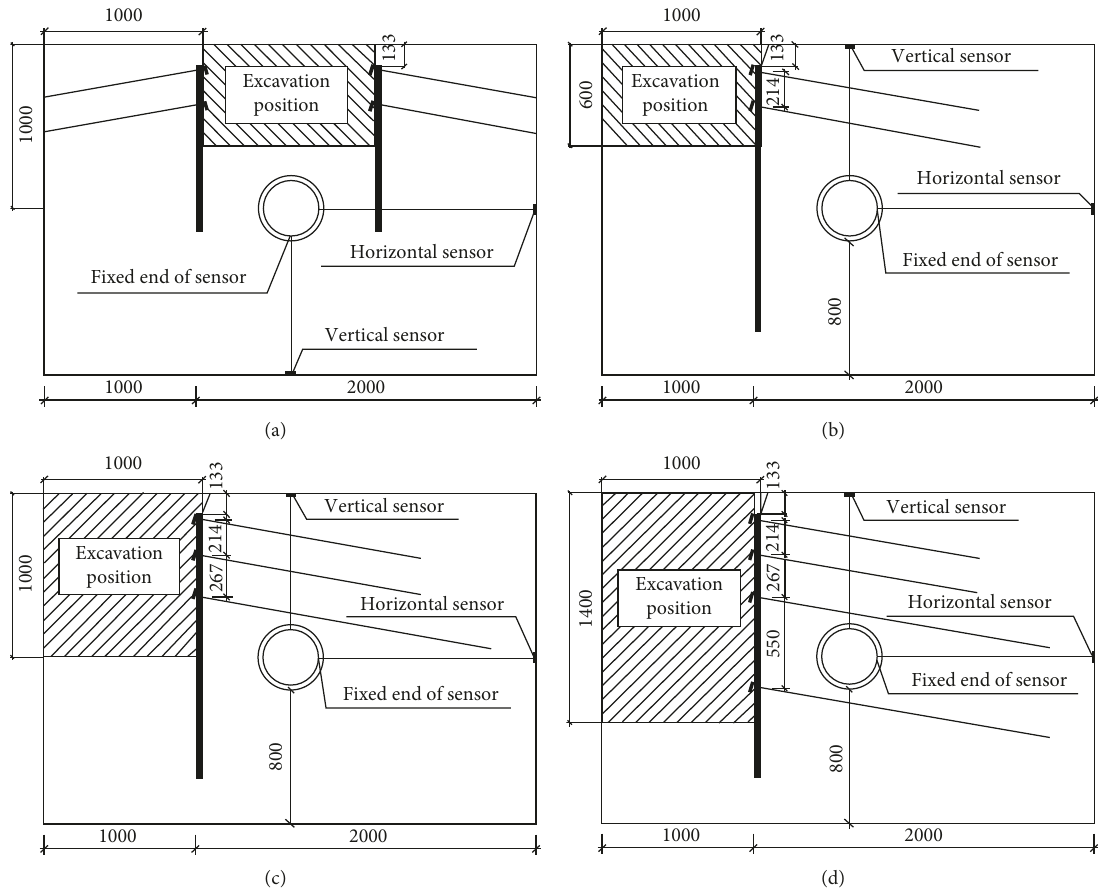
Figure 3: Layout of the support structure. (a) Scheme 1. (b) Scheme 2. (c) Scheme 3. (d) Scheme 4.